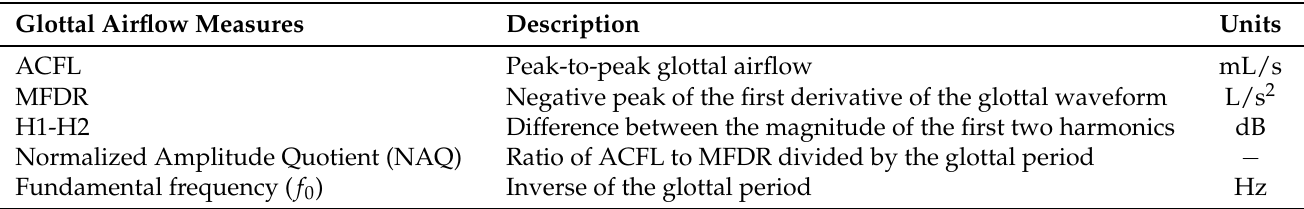
Table 1. Frame-based derived glottal airflow measures.